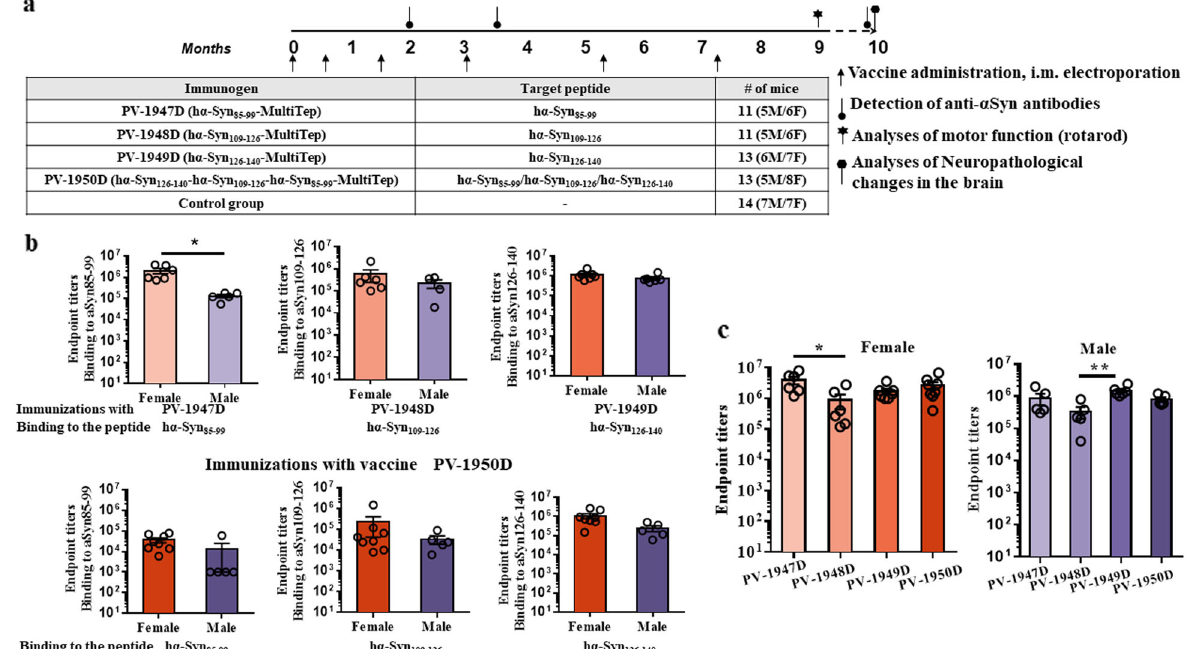
Fig. 1 PV-1947D, PV-1948D, PV-1949D, and PV-1950D induced high titers of antibodies speci fi c to appropriate peptide/s and full-length α -Syn in α -Syn/Tg D line mice. a Design of experimental protocol in h α -Syn Tg D line mice vaccinated with various MultiTEP-based DNA immunogens targeting different epitopes of h α -Syn. Mice were 2.5 – 4.5 mo of age at the start and 12 – 14 months old at the end of the experiment. b Endpoint titers of antibodies speci fi c to h α -Syn85 – 99, h α -Syn109 – 126, and h α -Syn126 – 140 peptides were detected in sera collected after the fourth immunization with indicated immunogens by ELISA. Error bars indicate the mean values of antibody titers ± SEM (* p < 0.05). PV-1950D induced higher responses to epitopes aa109 – 126 ( p < 0.05 for female and male mice) and aa126 – 140 ( p < 0.01 for female mice and p < 0.05 for male mice) compared with the epitope aa85 – 99. c Antibody titers of antibodies speci fi c to recombinant full-length α - Syn. Titers were signi fi cantly higher in PV-1947D vs. PV-1948D ( p < 0.05) in female and PV-1949D vs. PV-1948D ( p < 0.01) male mice groups. Error bars indicate the mean values of antibody titers ±